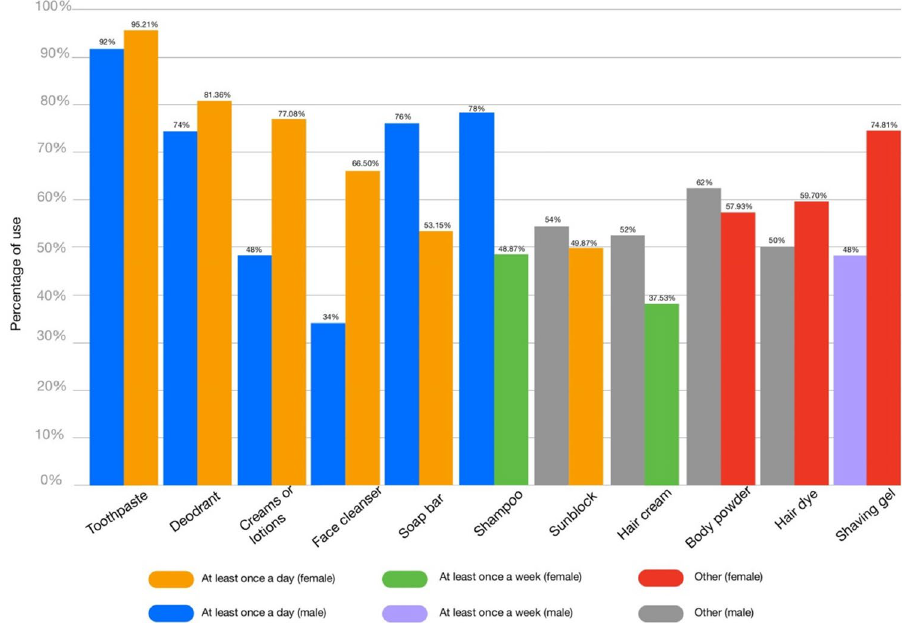
Figure 2. The most frequently used products according to the 447 participants.